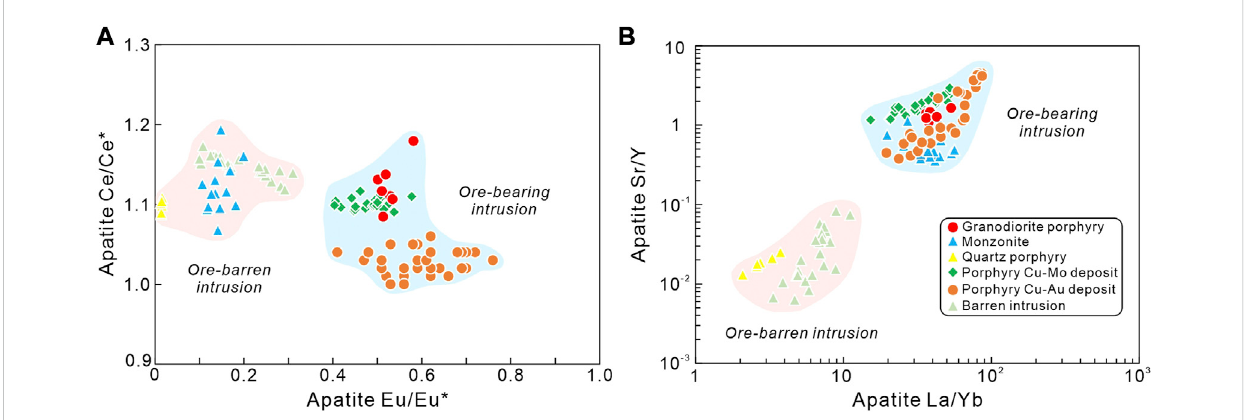
FIGURE 8 Plots of Ce/Ce* vs . Eu/Eu* (A) and Sr/Y vs . La/Yb (B) in the apatite of the Kalmakyr deposit and other porphyry deposits of the world. Compiled data are from Pan et al. (2016), Qu et al. (2019), and Qu et al. (2021).